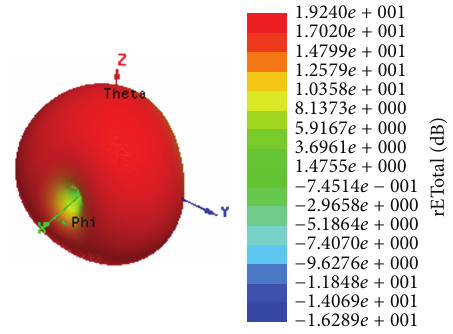
Figure 8: Simulated 3D radiation pattern plot for 8GHz.